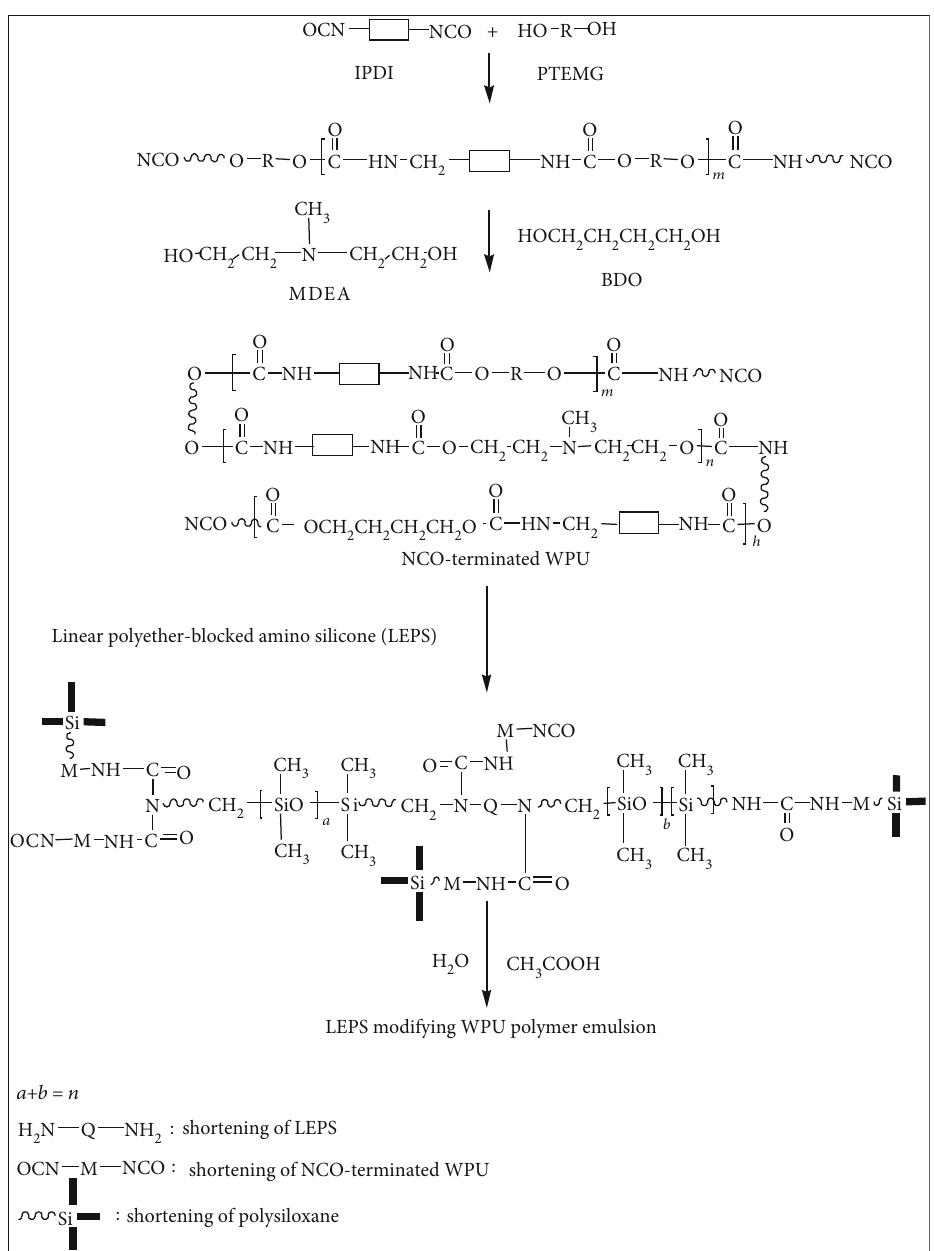
Figure 2: Preparation process of modi fi ed